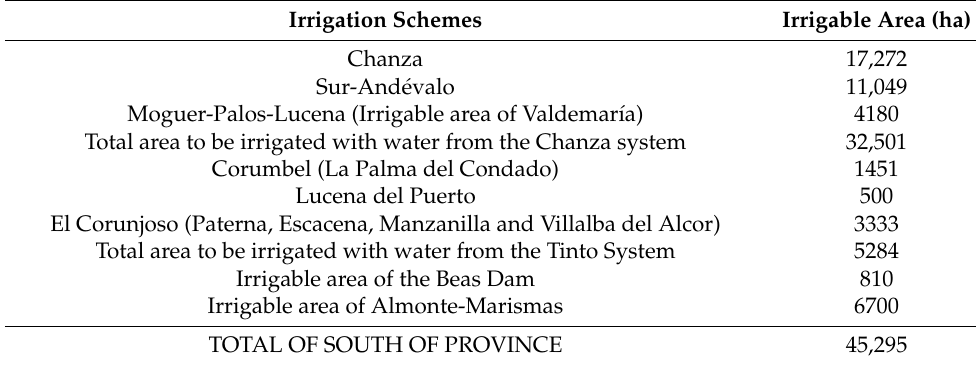
Table 2. Irrigation zone of the south of the Huelva province. Irrigation Schemes Irrigable Area